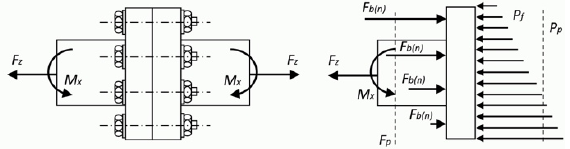
Figure 2. Bolted Joint with External loads